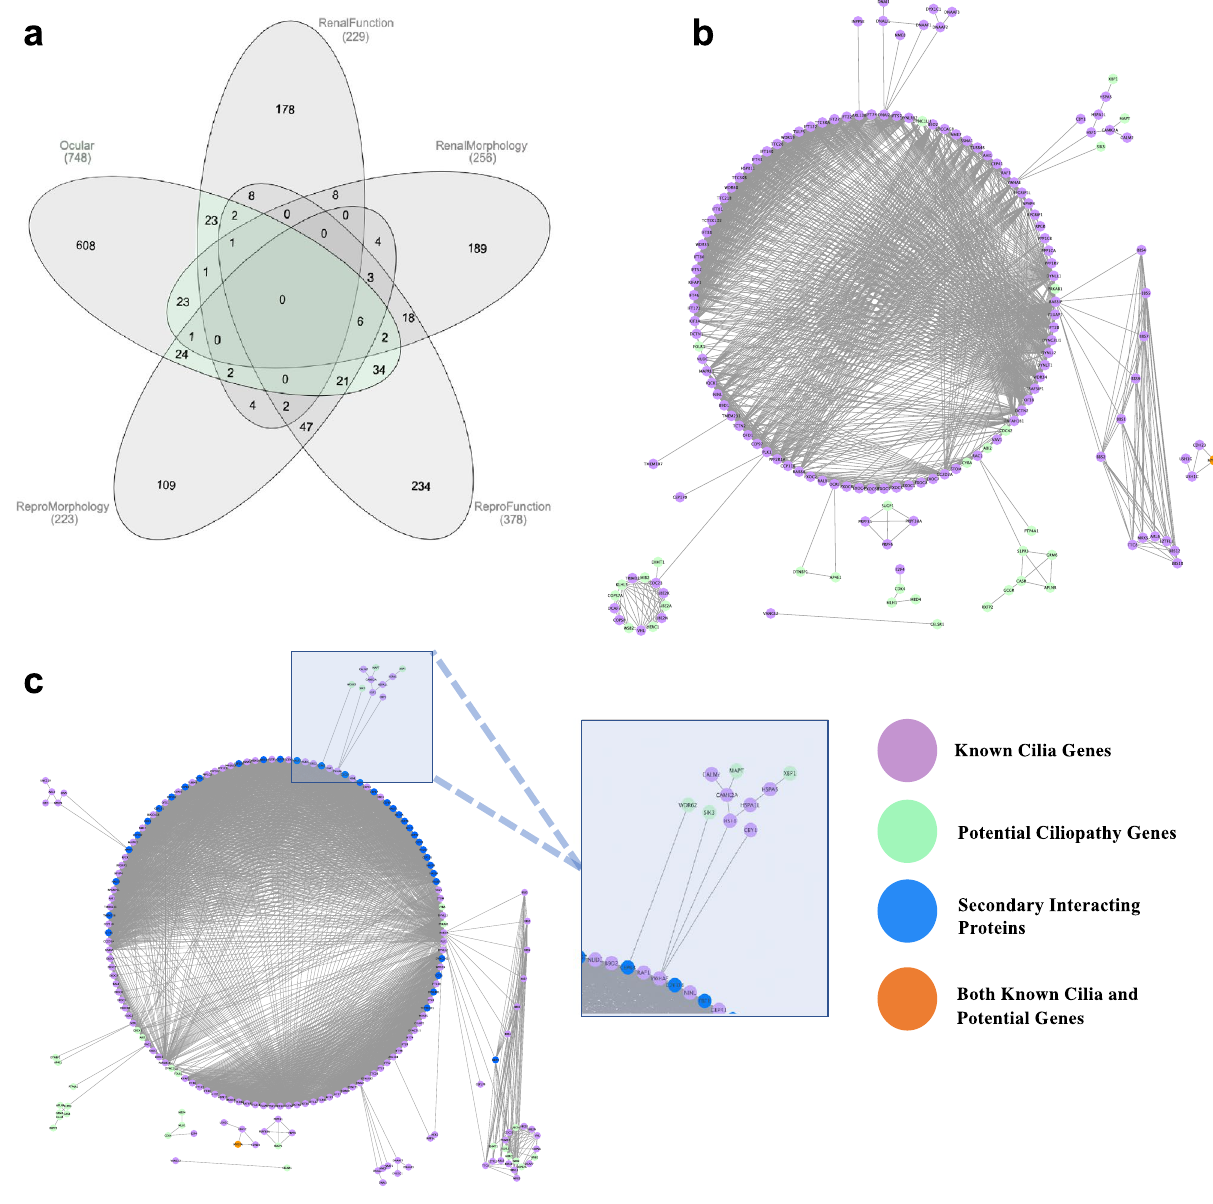
Figure 1. Identification of potential ciliopathy genes and protein network interactions of potential ciliopathy genes and known ciliopathy proteins. ( a ) Venn diagram showing intersection of IMPC genes associated with various phenotype subgroups, those highlighted in green outline have ocular and one or more other concomitant renal or reproductive trait abnormality and are subsequently considered “Potential ciliopathy genes” ( b ) STRING interaction map of known ciliopathy genes with potential ciliopathy genes. Proteins are shown as nodes on the map where green is indicative of a potential ciliopathy gene, purple shown known or gold standard ciliopathy genes, orange are those that were identified to be potential ciliopathy genes and are previously known as ciliopathy genes. Each line represents a STRING interaction score of greater than or equal to .9 based on 5 pieces of evidence: “experiments,” “databases,” “co-expression,” “neighborhood,” “gene fusion,” and “co-occurrence.” 24 of the 140 potential ciliopathy genes are shown to be directly interacting with known ciliopathy genes. ( c ) Incorporation of additional proteins or nodes into the network where blue nodes are genes not found in either gold standard or potential ciliopathy genes. Highlighted is an interacting oculorenal gene WDR62 which is predicted to interact with known ciliopathy genes through an additional protein